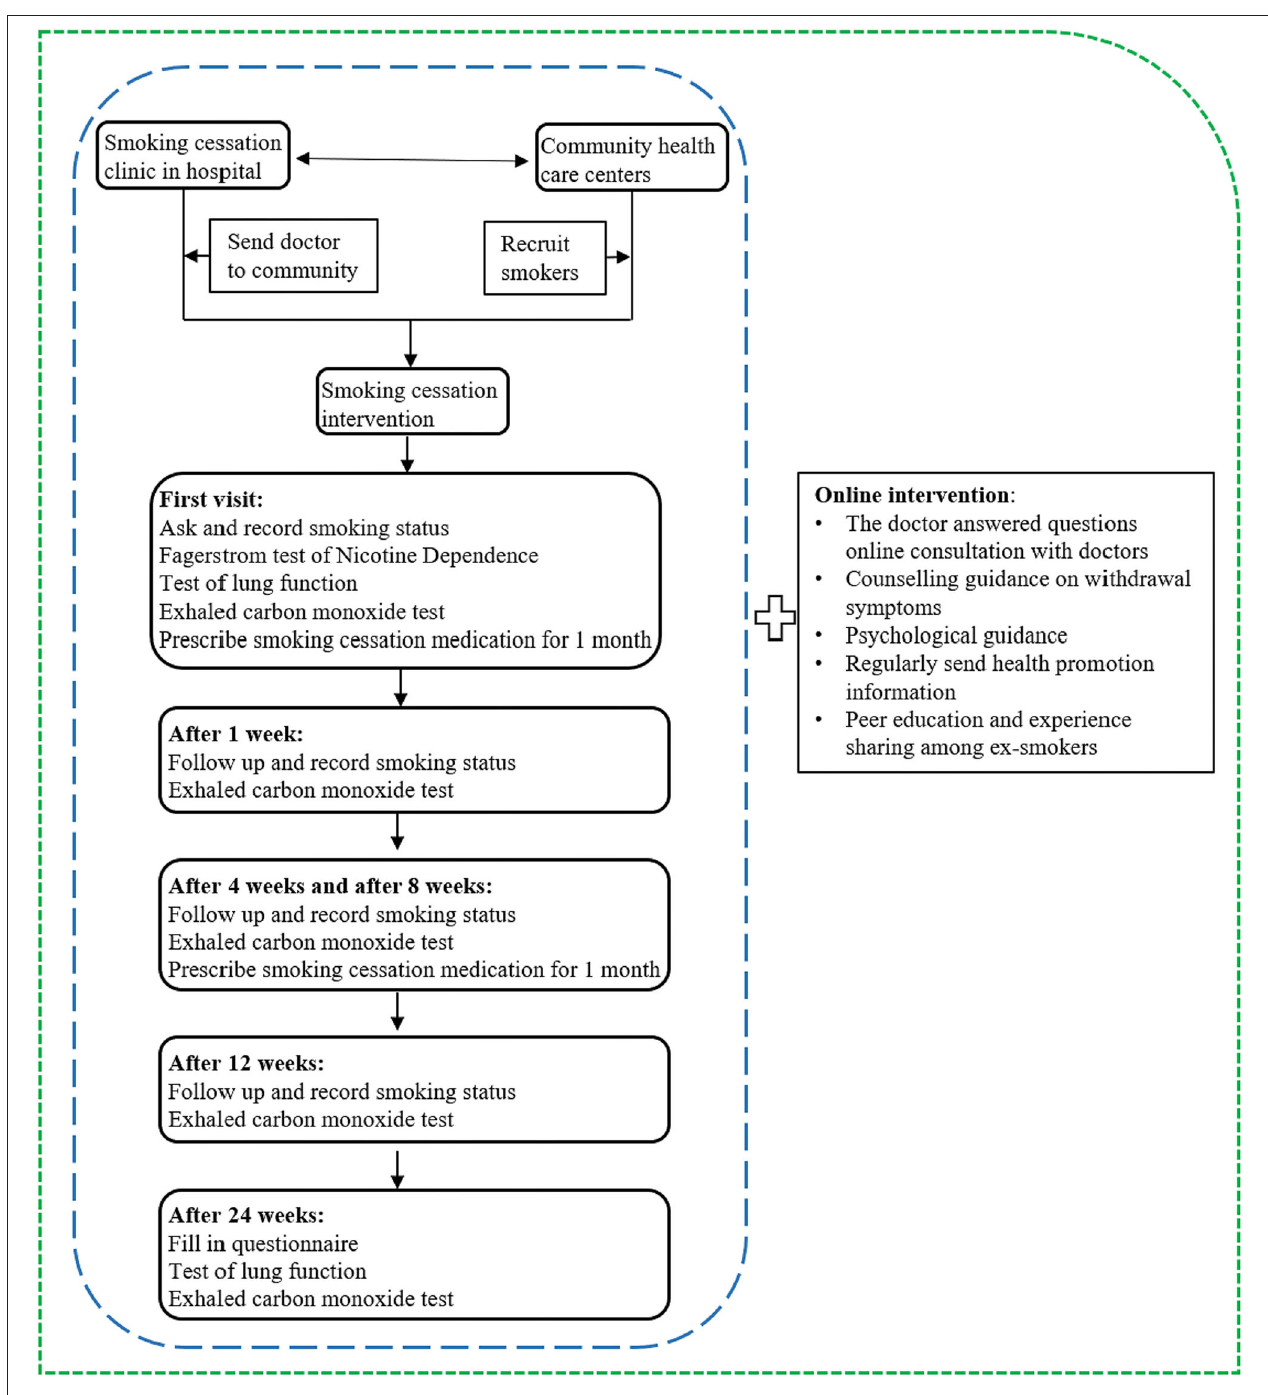
FIGURE 1 | The content of the intervention program. The blue circle and green circle respresent the specific measures of PI and CI, respectively.